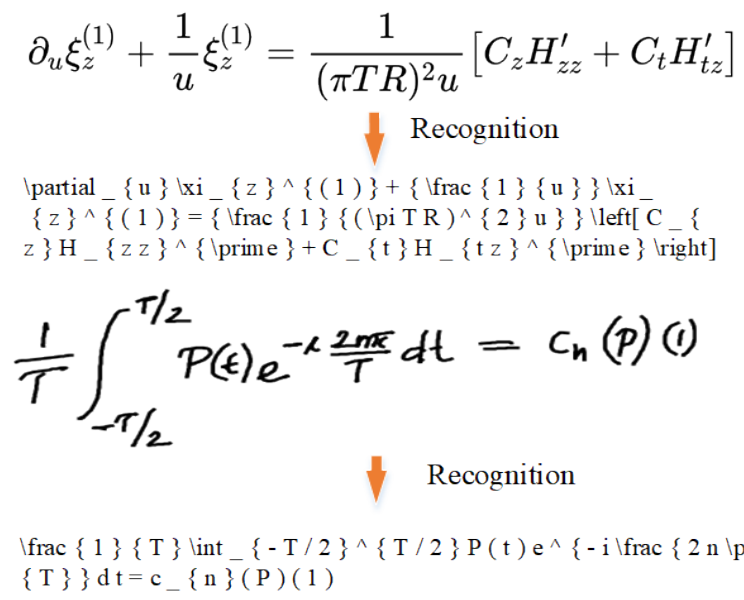
Figure 1. An example of LaTeX sequence generation from an image.